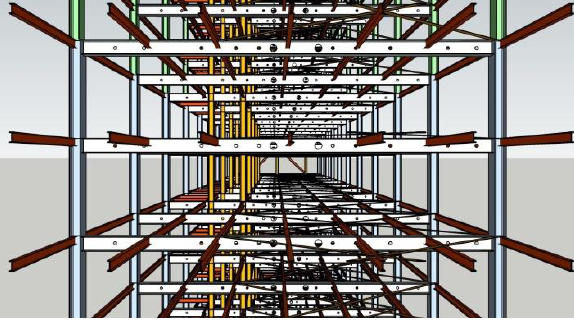
Figure 12: a perspective view of the steeel structure for the ENI Office Building in